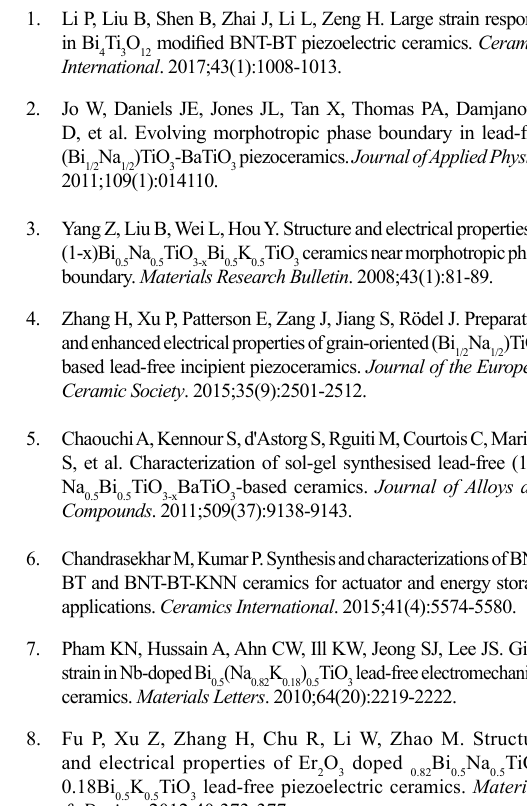
Figure 9. Cole-Cole plots of BNBT-0.035NT ceramic measured from 100 °C to 540